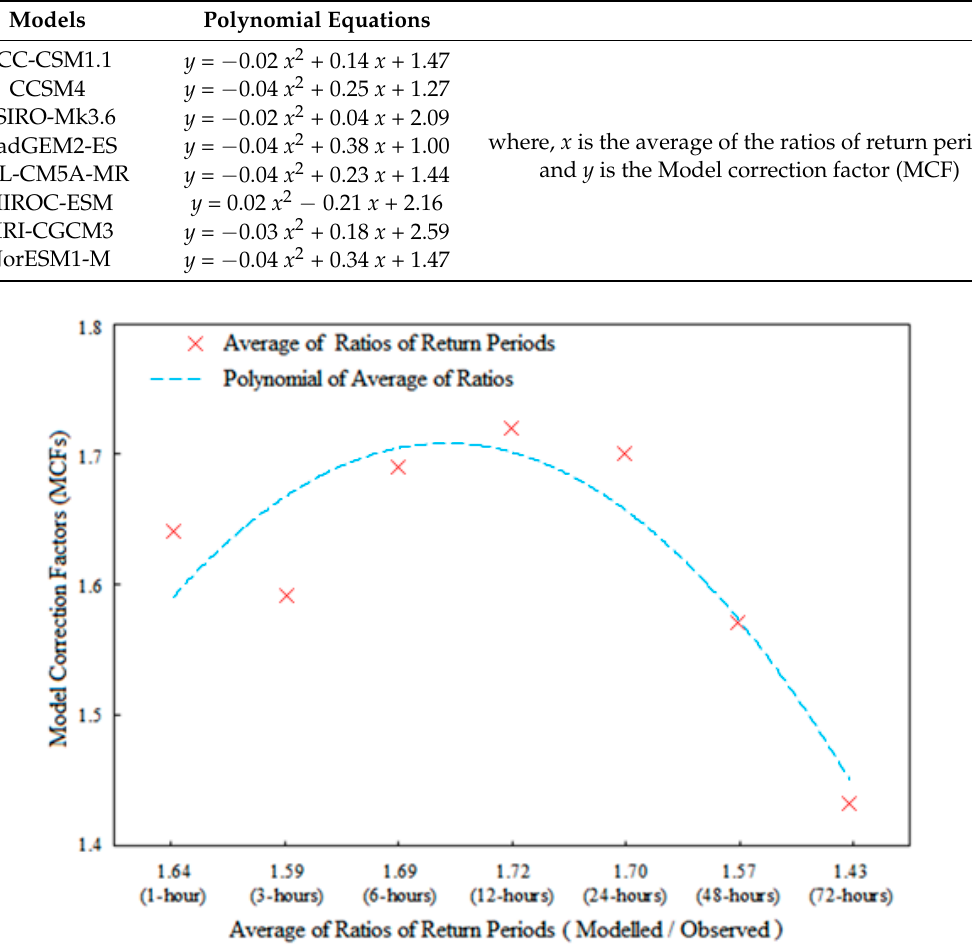
Table 8. Polynomials Equations for the GCMs used under RCP 4.5 at Kedah.